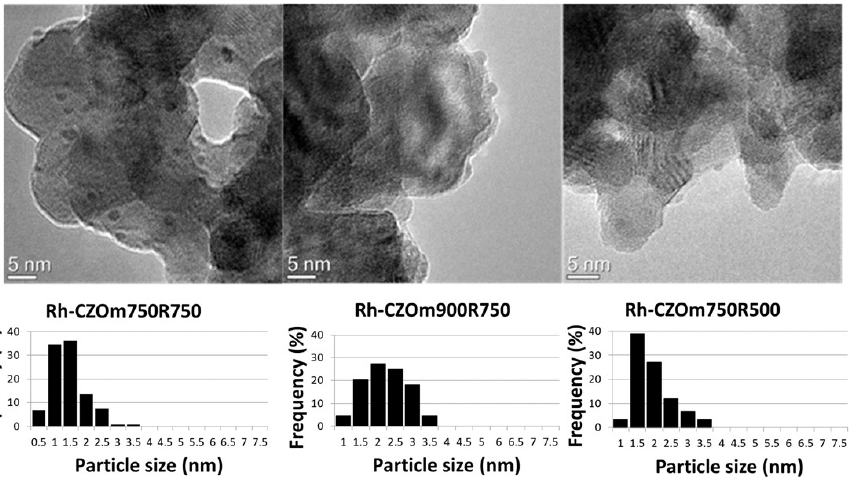
Figure 6. TEM images and particle size distributions of the catalysts calcined and reduced at different temperatures (Rh-CZOm750R750, Rh-CZOm900R750 and Rh-CZOm750R500).